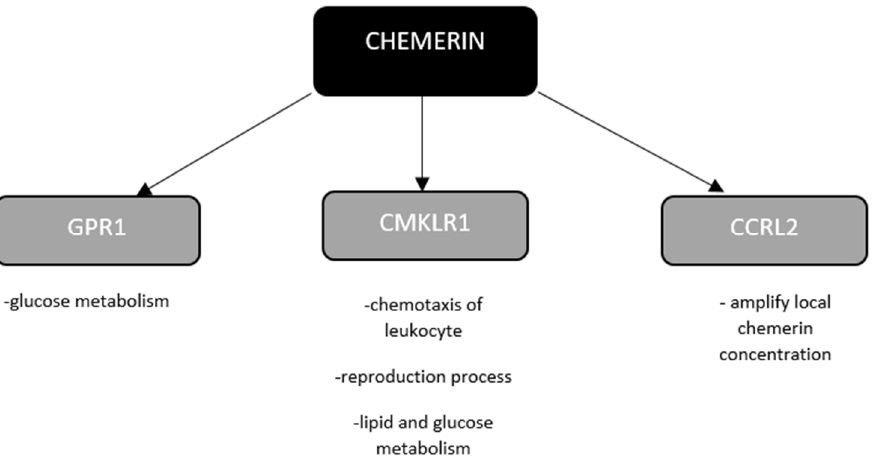
Figure 1. Mechanism of chemerin. Chemokine-like receptor 1 (CMKLR1), G-protein-coupled receptor 1 (gPR1) and C-C motif chemokine receptor-like 2 (CCRL2).